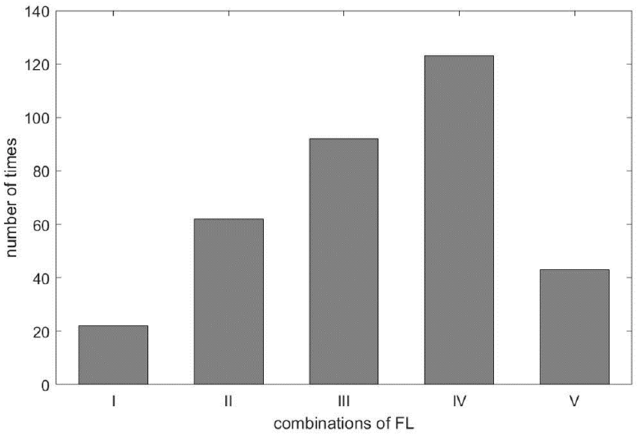
Figure 11. The distribution of frequency level combinations. Table 6. The comparison of RR using EEMD-SDF and other methods in MAE and rMAE.